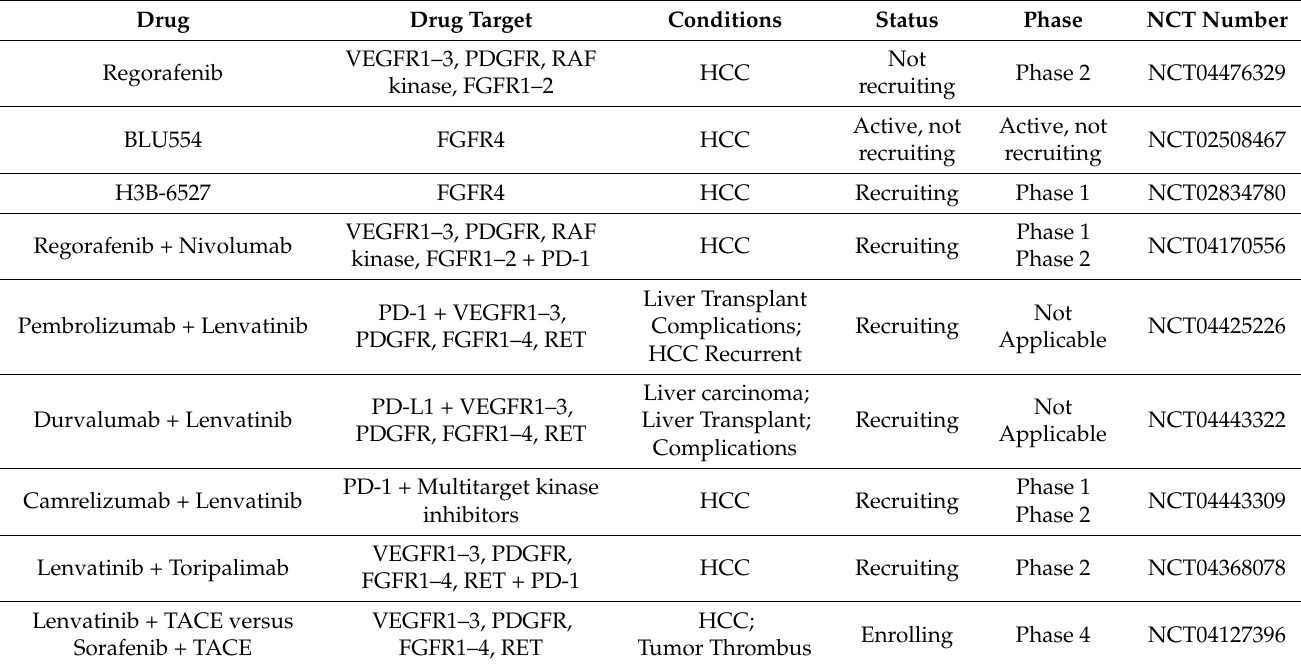
Table 2. Ongoing trials of FGF/FGFR targeted therapies for